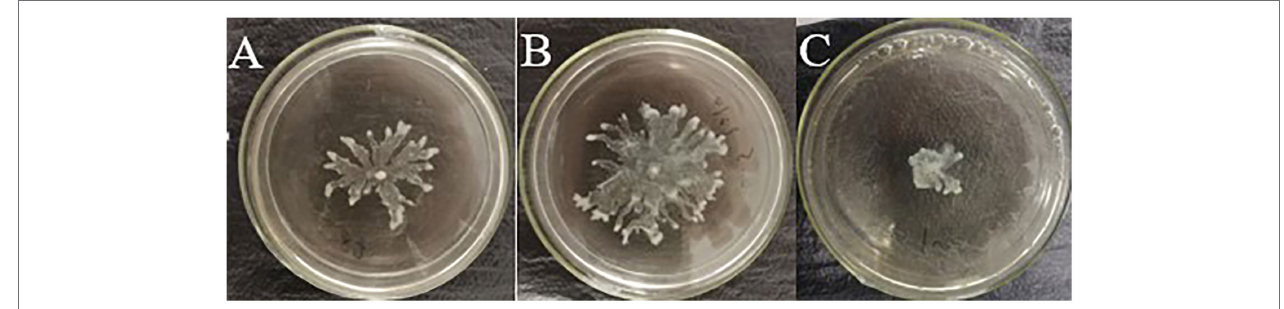
FIGURE 6 | Effect of compound Str7410 on swarming motility of Pseudomonas aeruginosa PAO1. (A) Negative control ( P. aeruginosa PAO1 alone). (B) Blank control ( P. aeruginosa PAO1 with supernatant of Staphylococcus aureus ATCC 25923 culture). (C) Treatment group ( P. aeruginosa PAO1 treated with supernatant of S. aureus ATCC 25923 culture and 10 μ M Str7410).